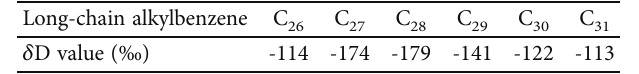
Table 3: δ D values of long-chain alkylbenzenes in Altay pyrolysis sample at 350 °